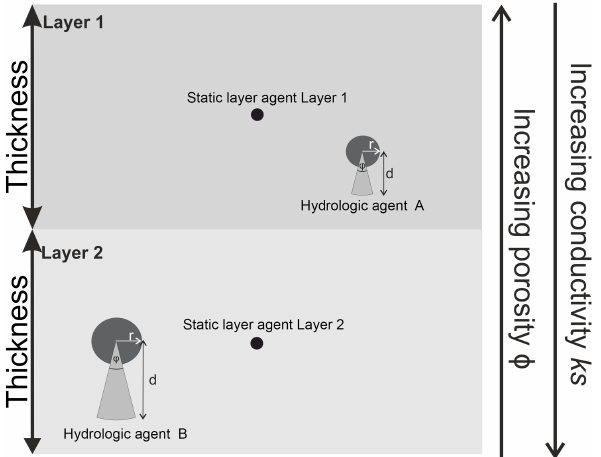
Figure 2. IPA scheme with two layers with decreasing porosity per depth and two hydrologic